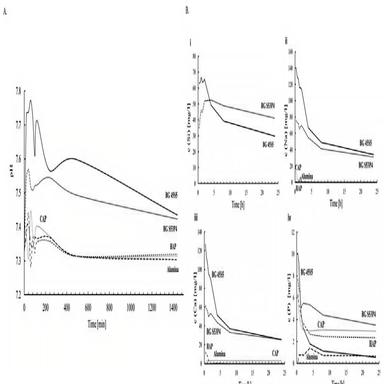
(a) pH changes of the Tris-buffer solution as functions of dissolution time in the studied materials (temperature were calculated to be at 37◦C). (b) Dissolution of ions from the studied materials into Tris-buffer solution as function of time. i. silicon, ii. sodium, iii. calcium, iv. phosphorous. For abbreviations, see 1a.